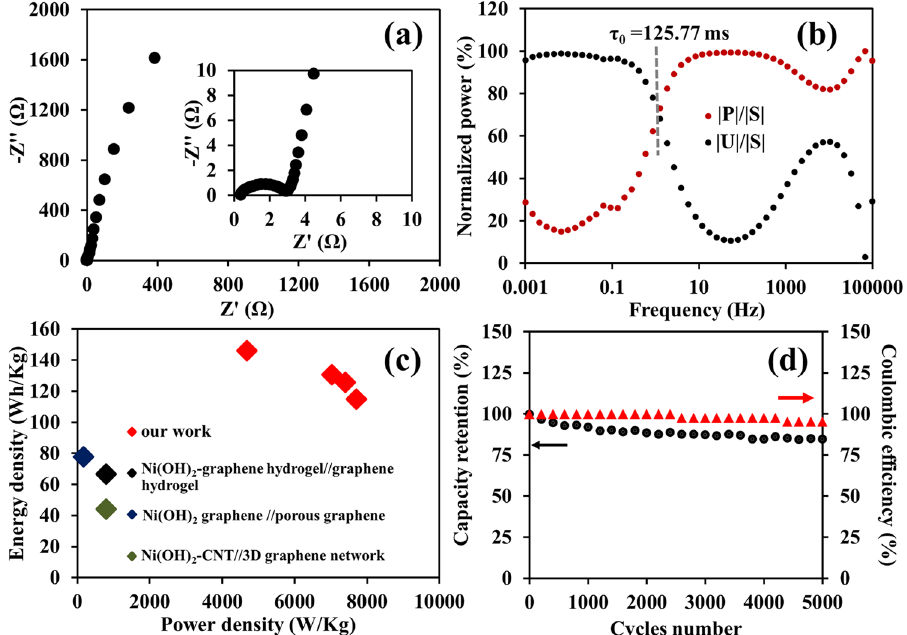
Figure 5. The electrochemical properties of the Ni(OH) 2 -N-rGO ae //N-rGO ae AES: ( a ) Nyquist plot, ( b ) the plots of normalized power with the frequency, ( c ) maximum power density vs. energy density compared with some previous report 34, 43, 44 and ( d ) the capacity retention over 5000 cycles at 1 A g − 1